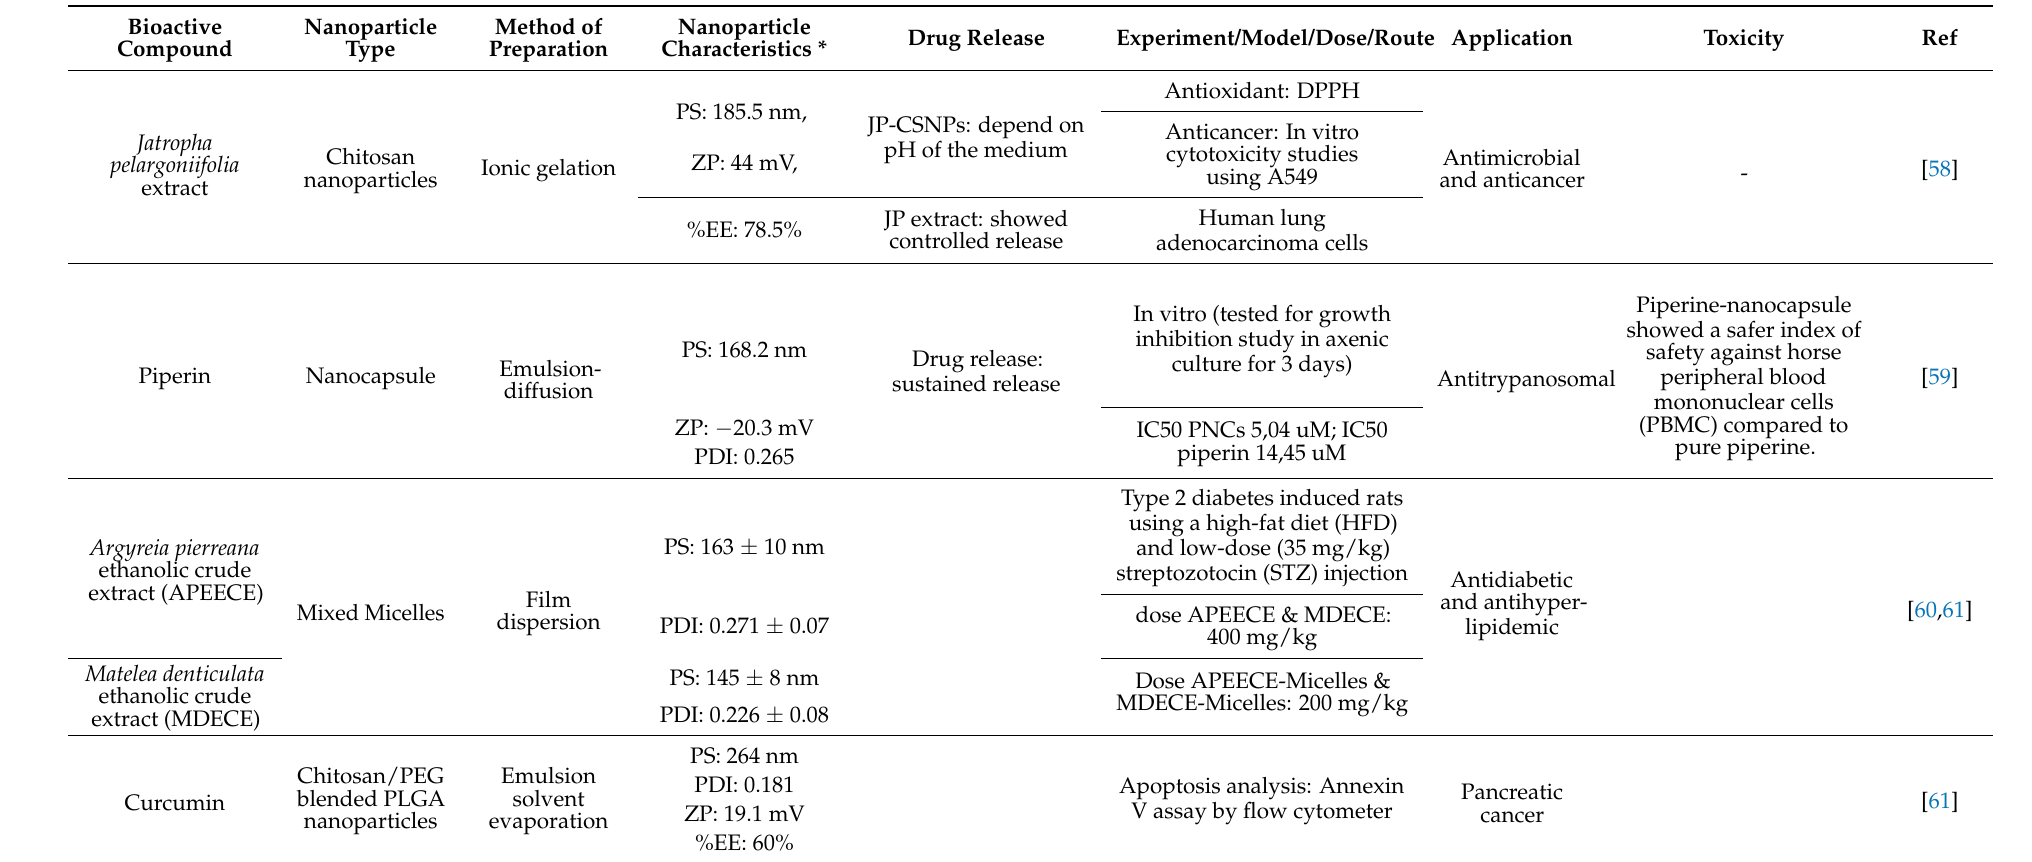
Table 3. Application of polymer-based delivery